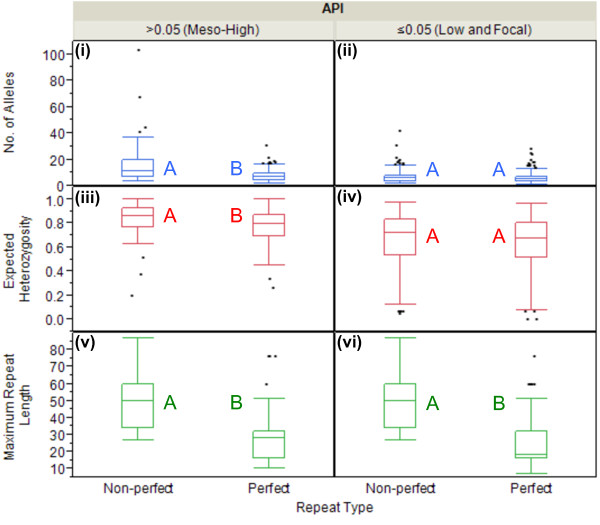
Repeat type as a function of MS diversity. For all MS markers combined, the box plots compare the mean number (no) of alleles per locus (y-axis, blue), expected heterozygosity (He) (y-axis, red) and maximum repeat length (y-axis, green) across different repeat types (x1°-axis), stratified API (x2°-axis). Character values (A and B) denote statistical significance between perfect and non-perfect repeat types, within each API category. In the API >0.05 stratum, non-perfect repeat types had a significantly higher mean no of alleles per locus (panel i) (p <0.0001, ANOVA), mean He(panel iii) (p = 0.0192, ANOVA) and mean maximum repeat length (panel v) (p <0.0001, ANOVA) than perfect repeat types. In the API ≤0.05 stratum, non-perfect repeat types had a significantly higher mean maximum repeat length (panel vi) (p <0.0001, ANOVA) than perfect repeat types. No significant differences were found between repeat types for either the mean no of alleles per locus (panel ii) or mean He in the API ≤0.05 stratum (panel iv).